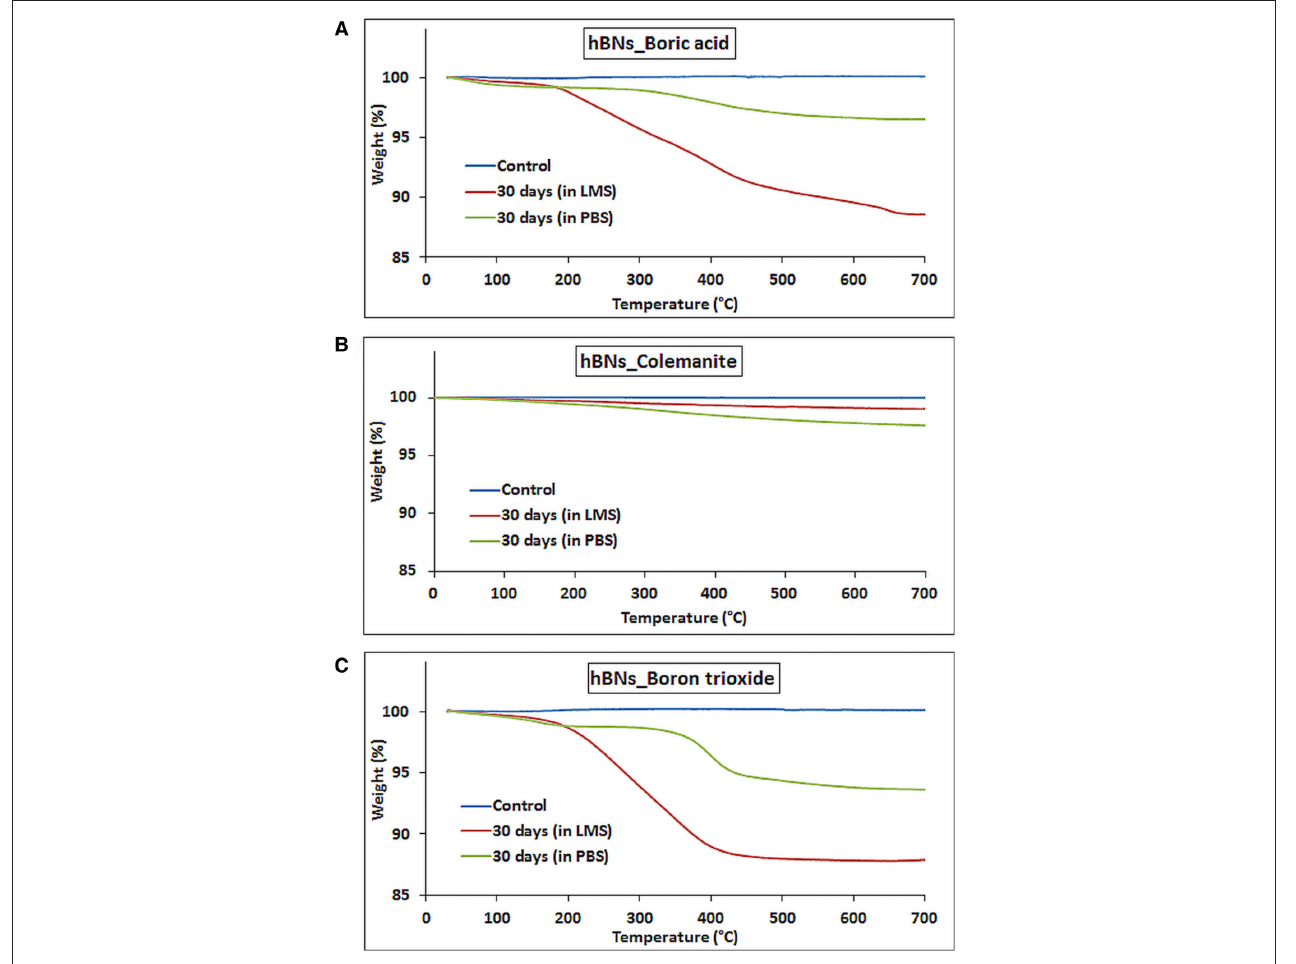
FIGURE 5 | TGA curves of hBNs before and after biodegradation treatment. (A) hBNs_boric acid, (B) hBNs_colemanite, and (C) hBNs_boron trioxide.